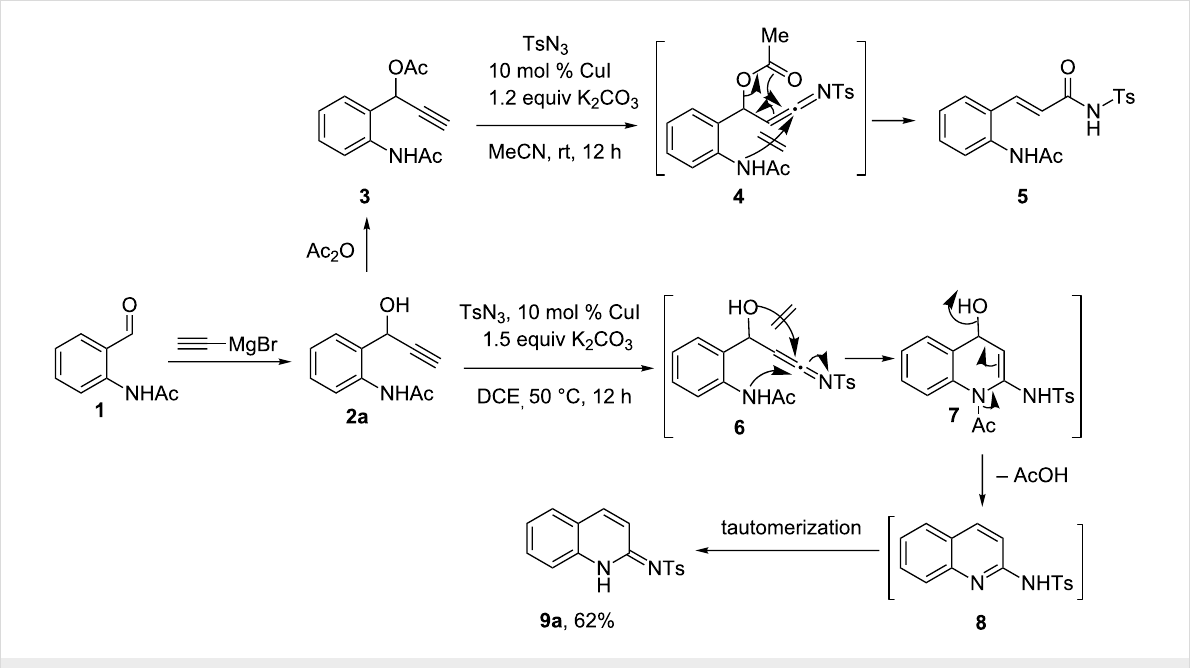
Scheme 2: Intramolecular nucleophilic capture by